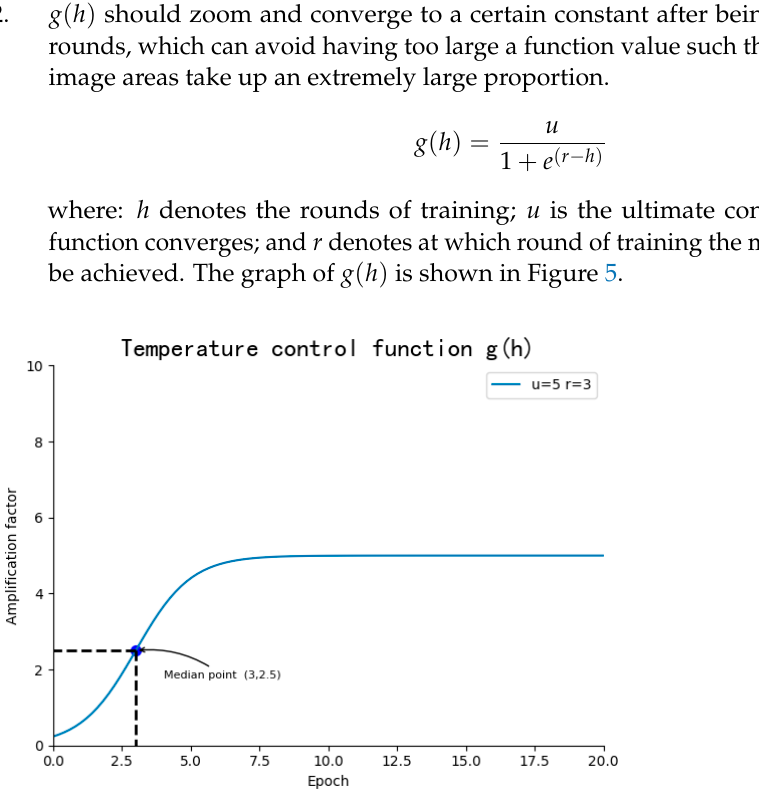
Figure 5. Graph of the temperature control function, with the values of the standard model’s parameters at the upper right corner.